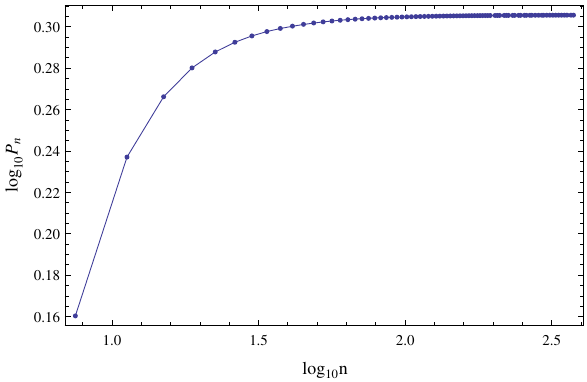
Fig. 2 The power spectrum obtained by numerically solving the per- turbations with ˜ m = 1000